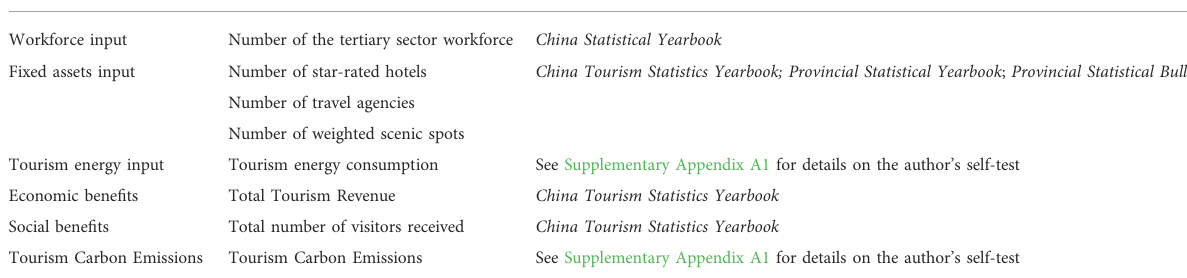
TABLE 1 TET input-output indicators and data